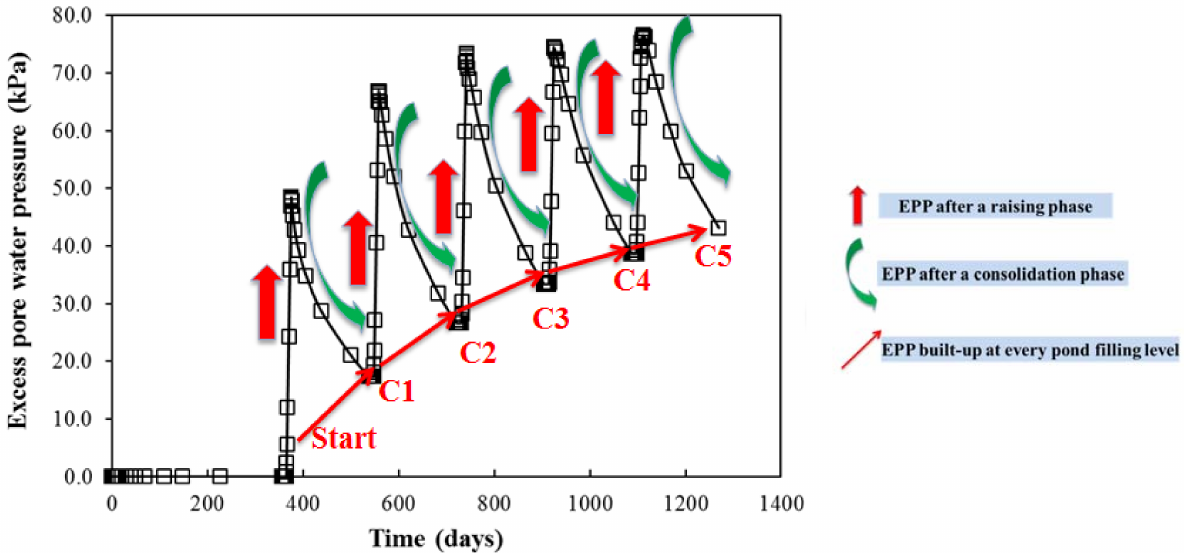
Figure 11. Concept of excess pore water pressure build-up during the stage of construction (point B and PFR = 10 m/year).